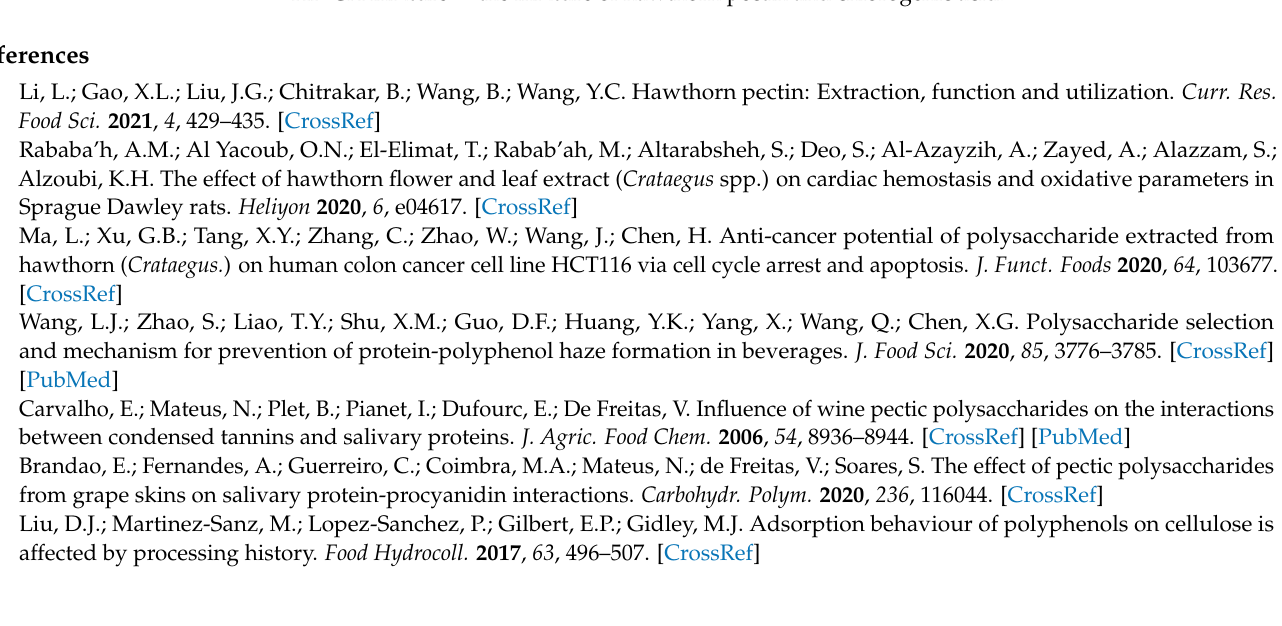
Table S2: Analysis of HPLC results of HP; Table S3: Parameters of different adsorption kinetic models; Table S4: Parameters of different adsorption isotherm models; Figure S1: Adsorpption curves of EC and CA on HP fitting by (A) Langmuir isotherm model and (B) Freundlich isotherm model; Figure S2: The turbidity characteristics of interaction between HP and polyphenols (EC and CA). The measure of absorbance at 650 nm after interactions in 0.1 M citrate/phosphate buffer pH 3.8 (in triplicate). (A) Variation of absorbance of HP at different concentrations with polyphenols (0.08 mg/mL). (B) Variation of absorbance of polyphenols at different concentrations with HP (0.4 mg/mL); Figure S3: UV-VIS scanning results of HP, EC and HP-EC mixture (A); CA and HP-CA mixture